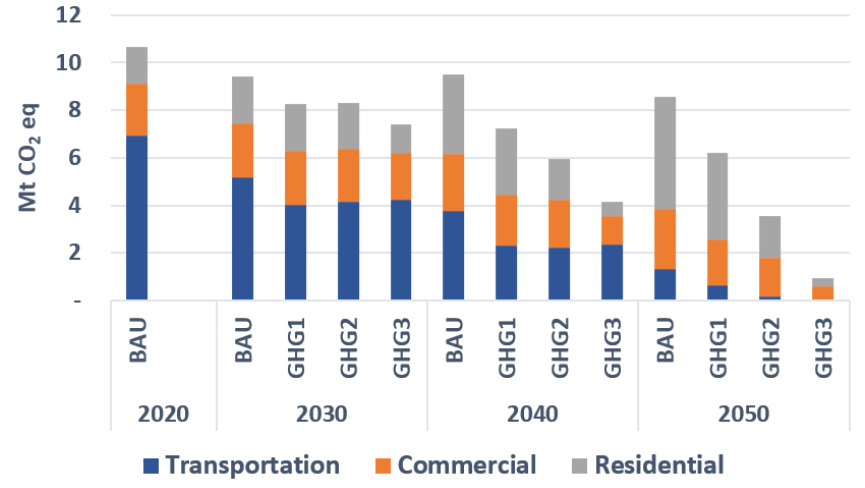
Figure 4. Breakdown of GHG emission reductions by sectors and environmental